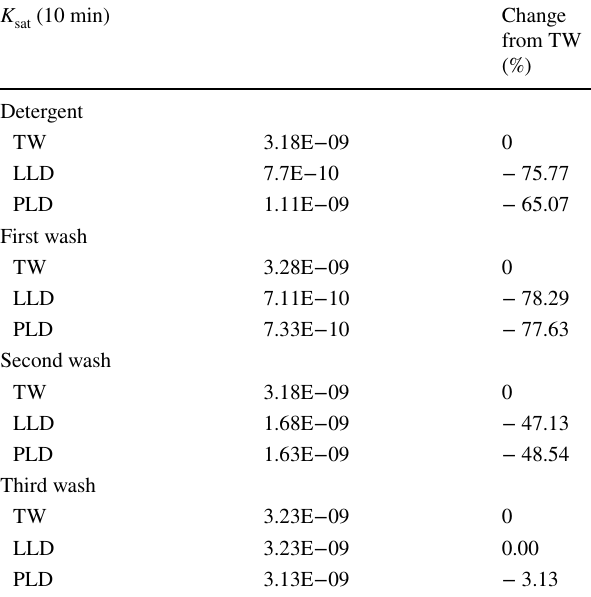
Table 3 Mean K sat for 10 min of soils irrigated with tap water (TW),